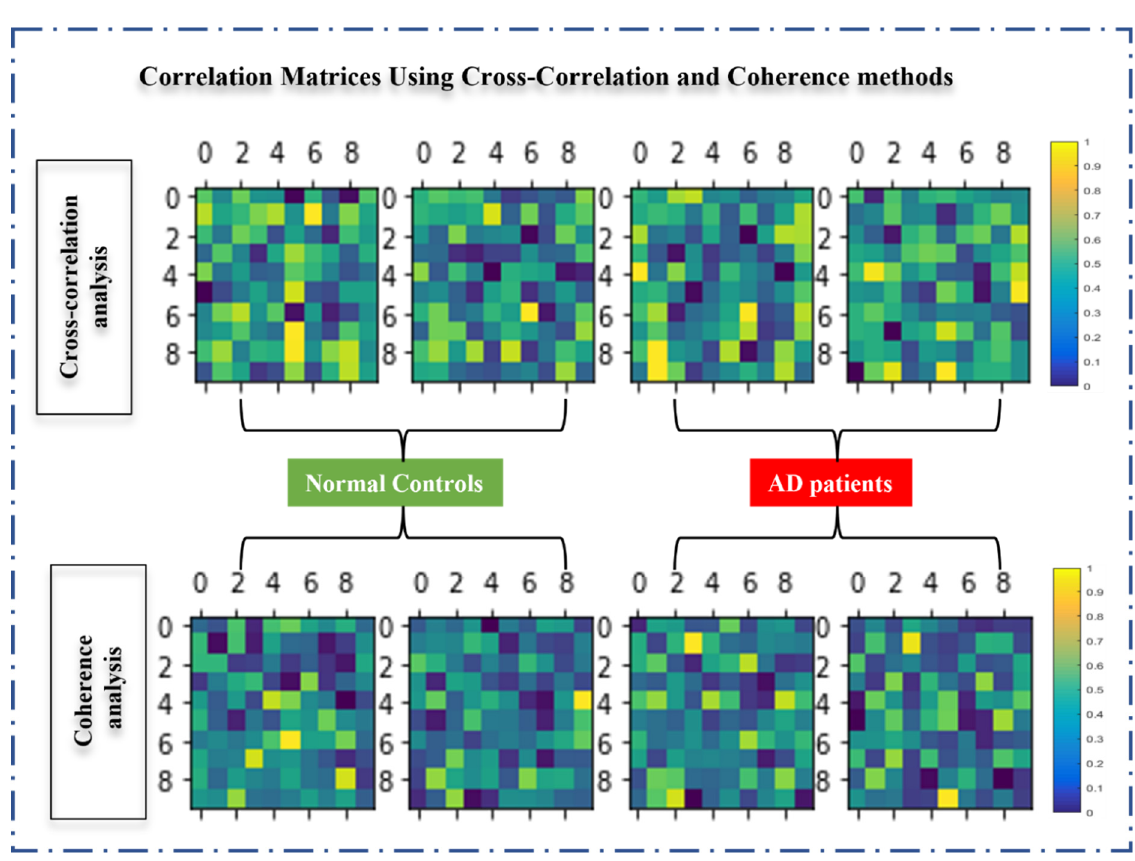
Figure 3. Correlation matrices were generated using CCA and CA for NCs and AD patients. Both methods measure the FC between white and grey matter at resting-state. The intensity of FC is highest at yellow blocks (strong correlation) and lowest at dark blue blocks (weak